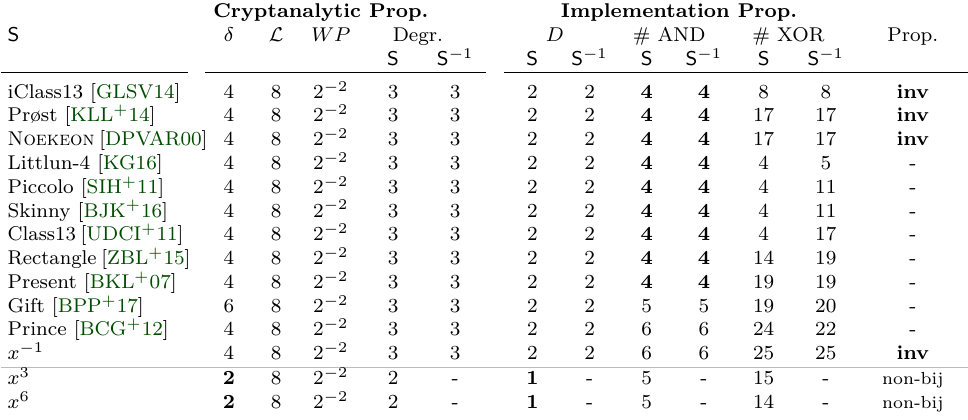
Table 2: Overview of optimization for various 4-bit S-boxes. The rows marked “inv” are